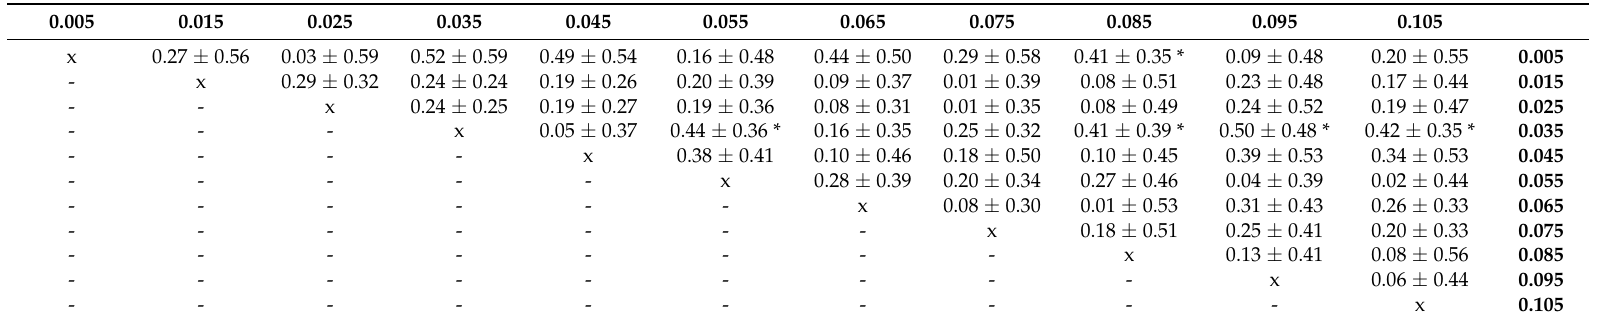
Table 1. Effect Sizes and accompanying 90% Confidence Intervals for solution concentrations. Small effects with confidence intervals not overlapping zero are marked with an asterisk